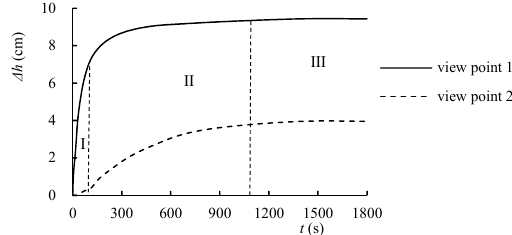
Figure 11. Groundwater level change in observation points.